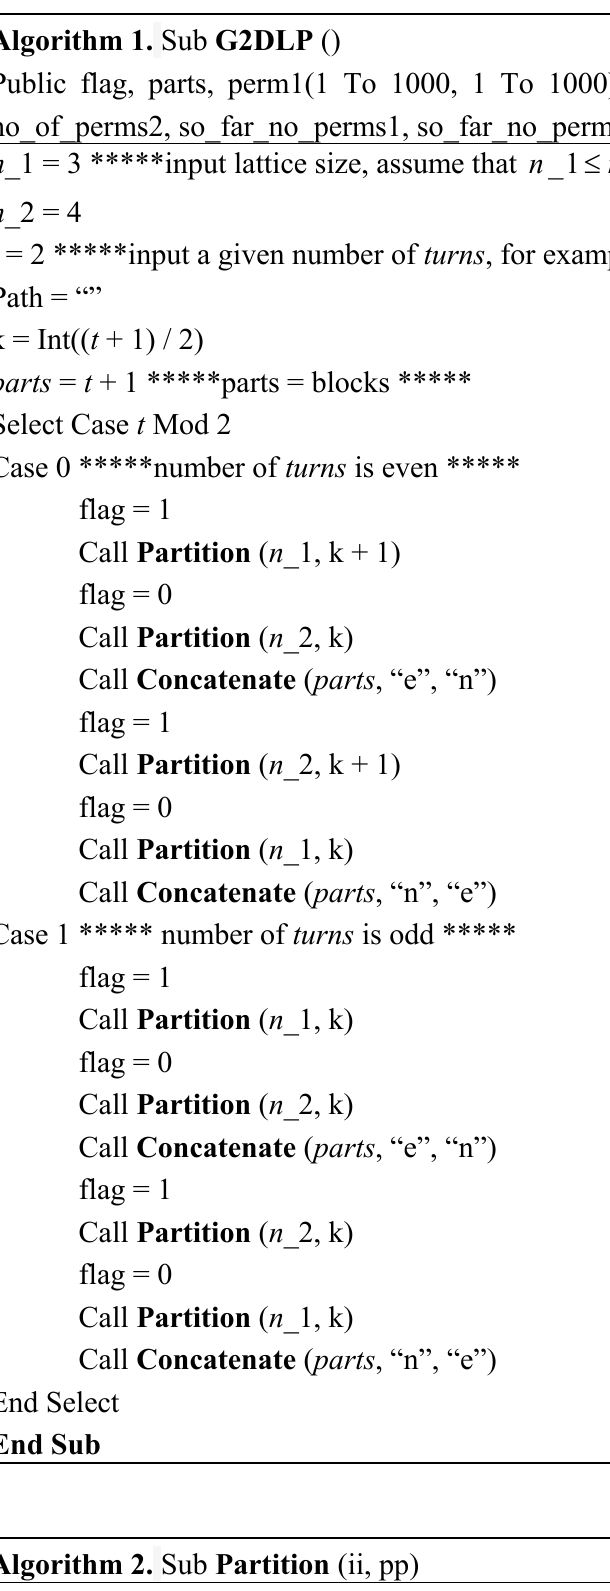
Algorithm 1. Sub G2DLP ()